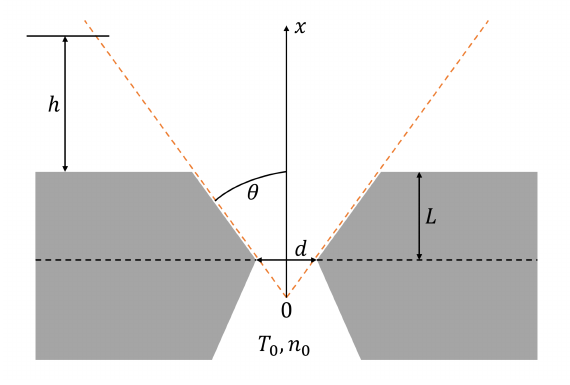
Figure 2. Sketch of a conical nozzle. The quantities for the solenoid valve are d = 500 µ m, L = 250 µ m and θ = 45 ◦ .